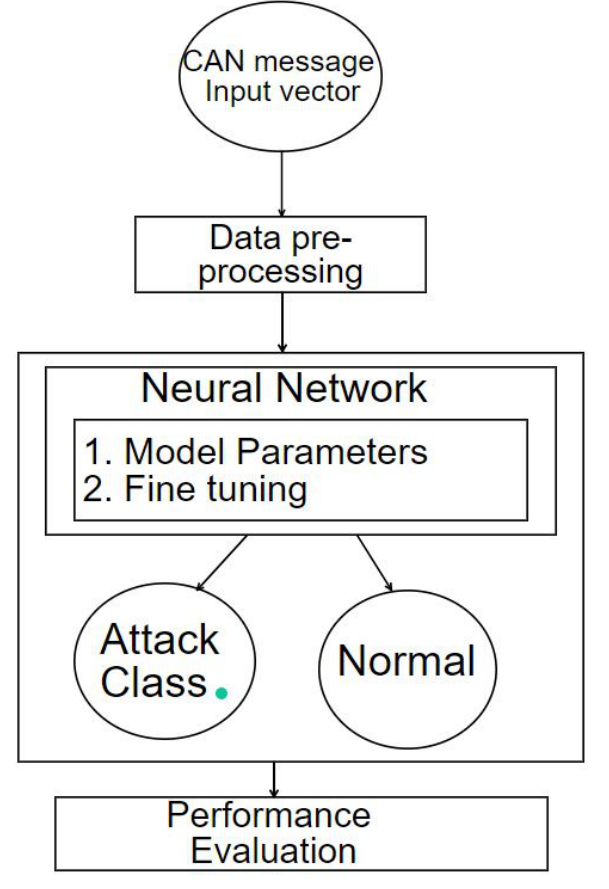
Figure 8. Flow chart of implemented